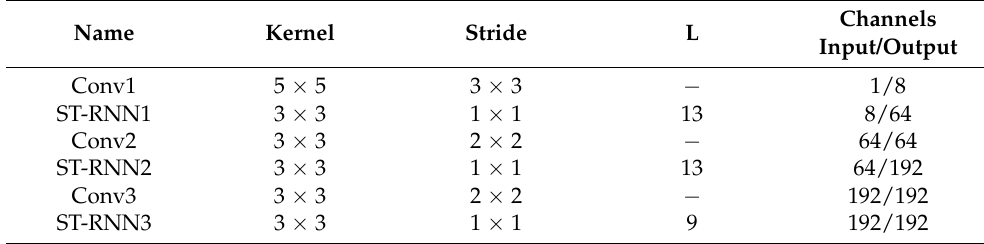
Figure 2. The overall architecture of our 2S-STRef network, which is composed of two stages including the spatiotemporal prediction stage and detail refinement stage. Detailed structure parameters can be found in Tables 1 and 2. Table 1. General structure of the encoder of the proposed spatiotemporal RNN model (stage 1).